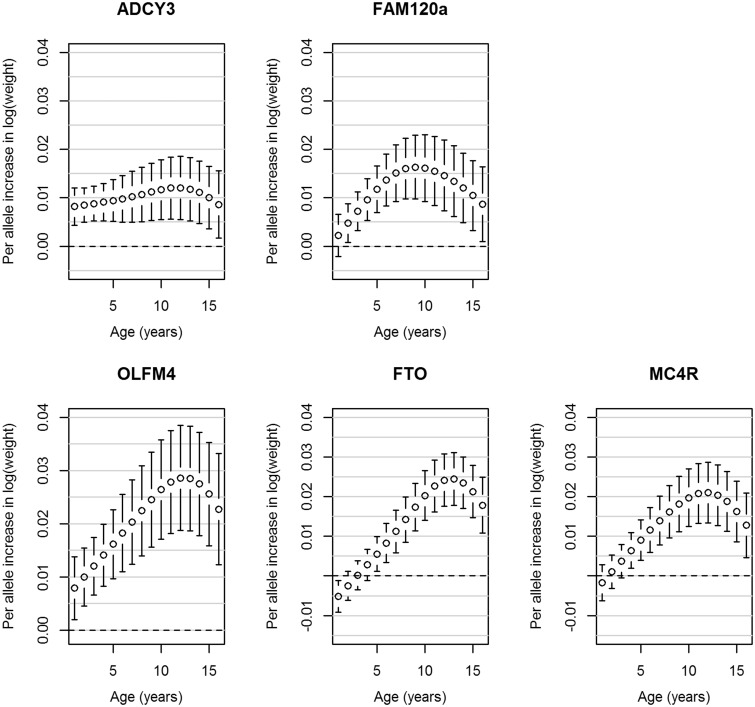
Associations from the ALSPAC cohort between the genome-wide significant SNPs and weight from age one to 16 years. Error bars represent the regression coefficient of weight on the natural log scale and 95% confidence intervals derived from the longitudinal additive genetic models. The SNPs are aligned to the minor allele.